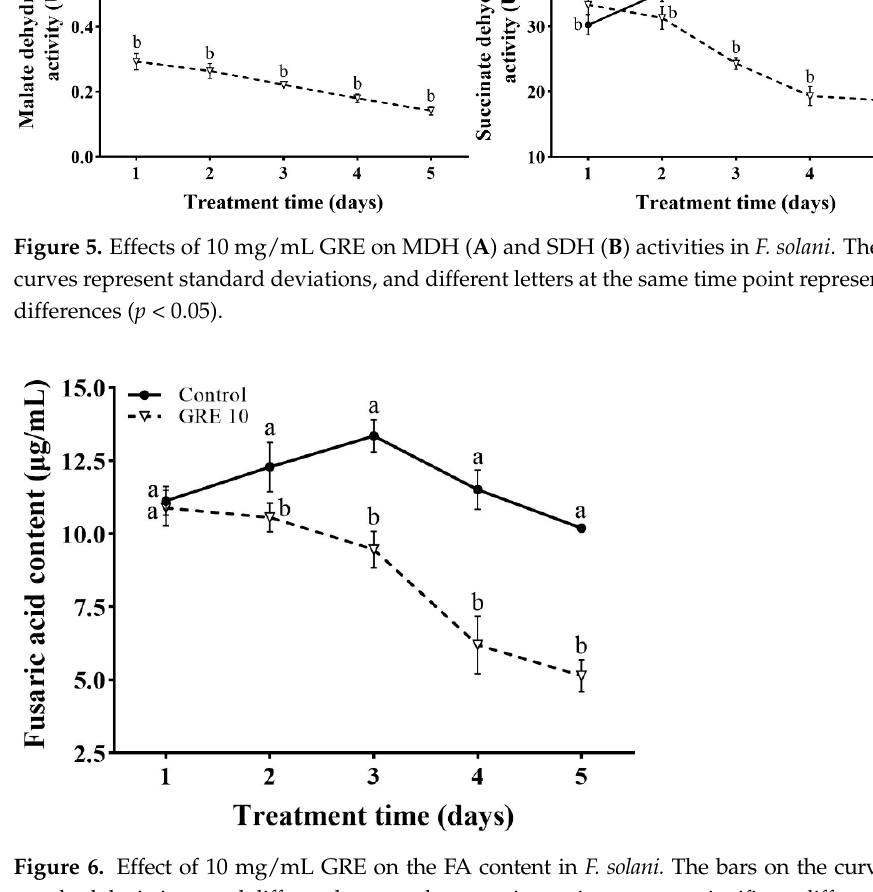
Figure 5. Effects of 10 mg/mL GRE on MDH ( A ) and SDH ( B ) activities in F. solani . The bars on the curves represent standard deviations, and different letters at the same time point represent signifi- cant differences ( p < 0.05).